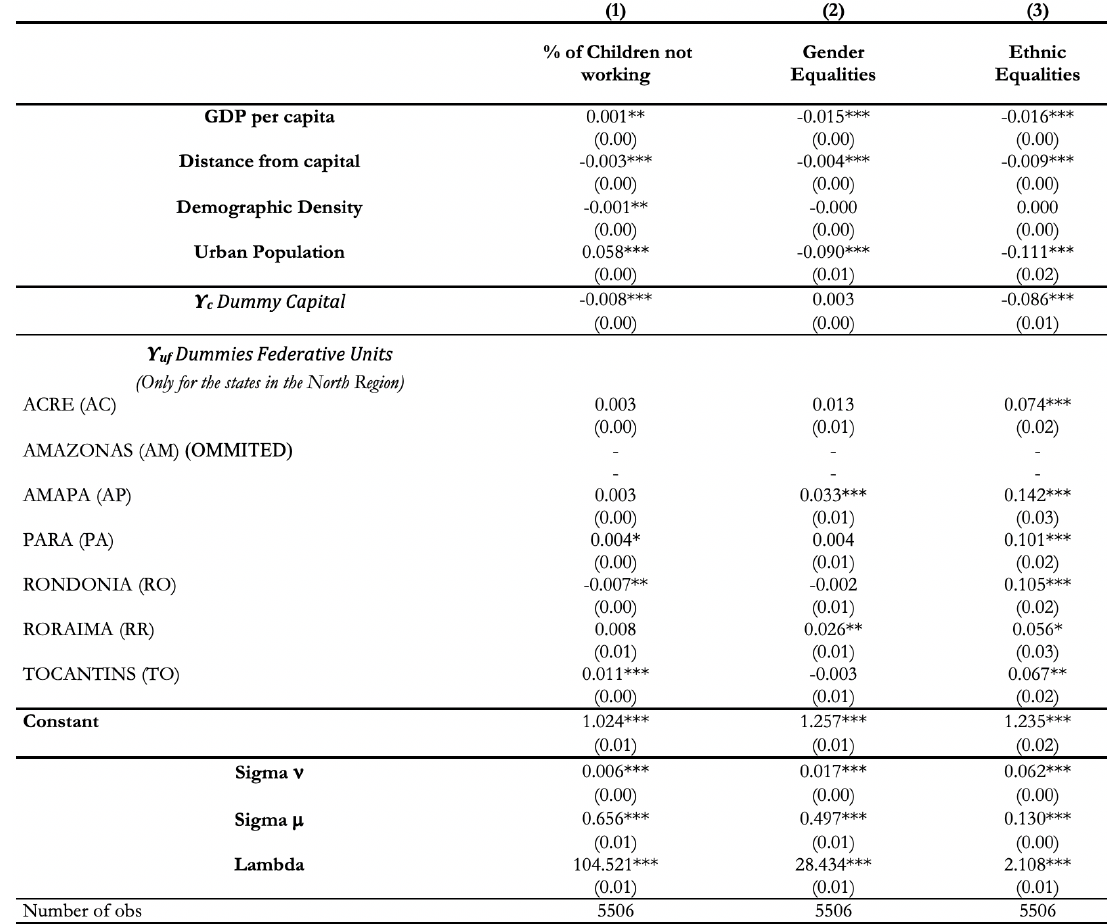
Table 4: Labor Standards Regressions MODEL B